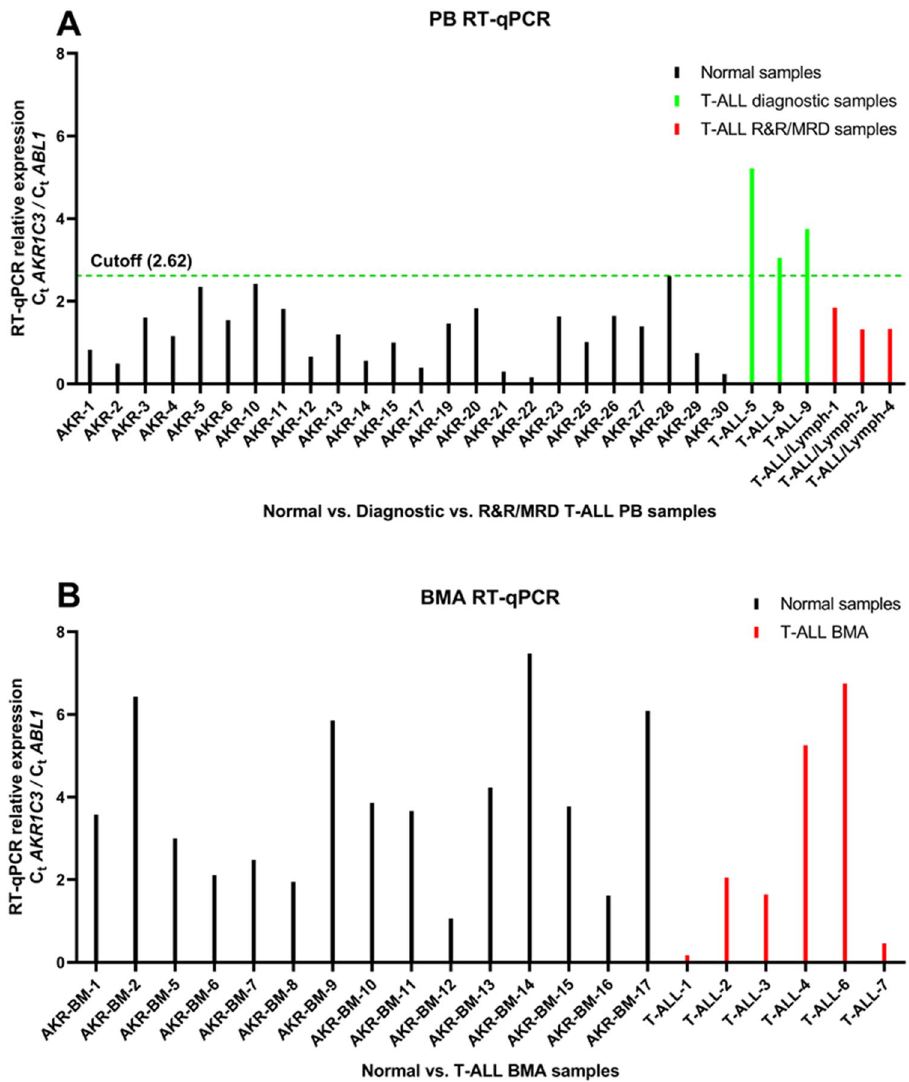
Figure 3. AKR1C3 RT-qPCR in blood and bone marrow. RT-qPCR values of diagnostic peripheral blood ( A , green), R&R/MRD peripheral blood ( A , red), and marrow aspirates ( B , red). Diagnostic peripheral blood samples surpassed the calculated cutoff value (Table